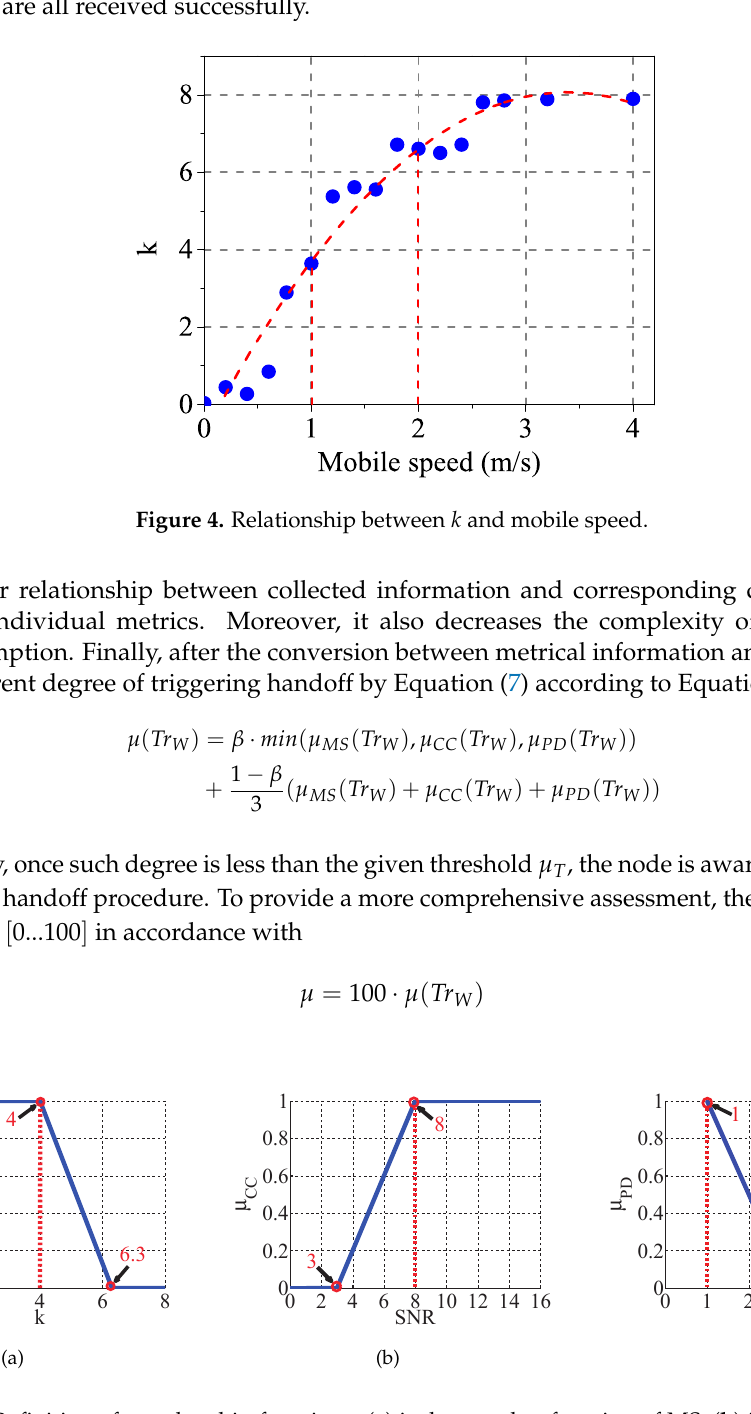
Figure 5. Definition of membership functions: ( a ) is the member function of MS, ( b ) is the member function of CC and ( c ) is the member function of